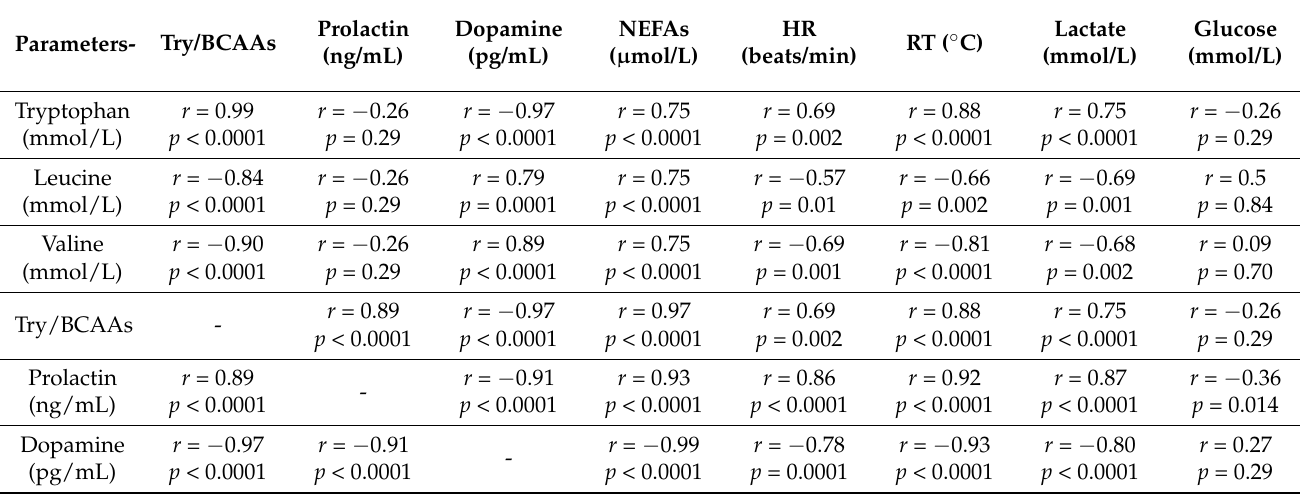
Figure 3. Serum amino acids (e.g., tryptophan, leucine, valine), Try/BCAAs ratio, NEFAs, dopamine, and prolactin values measured in each competing horse before the exercise event (T0), at the end of the competition stage (5 min ± 10 s) following the cessation of the exercise, T POST5 ), and 30 min after the end of the competition (T POST30 ). Table 1. Coefficients of correlation among peripheral modulators of serotoninergic function (e.g., tryptophan; leucine; valine; Try/BCCAs ratio; NEFAs), neurohumoral factors (e.g., dopamine and prolactin), and indices of athletic performance (e.g., heart rate, HR; rectal temperature, RT; blood lactate concentration; blood glucose concentration) in jumper horses throughout the monitoring period. Values and age calculated for males and females of foals and for males and females of horses during the monitoring period. p -Values < 0.05 were considered statistically